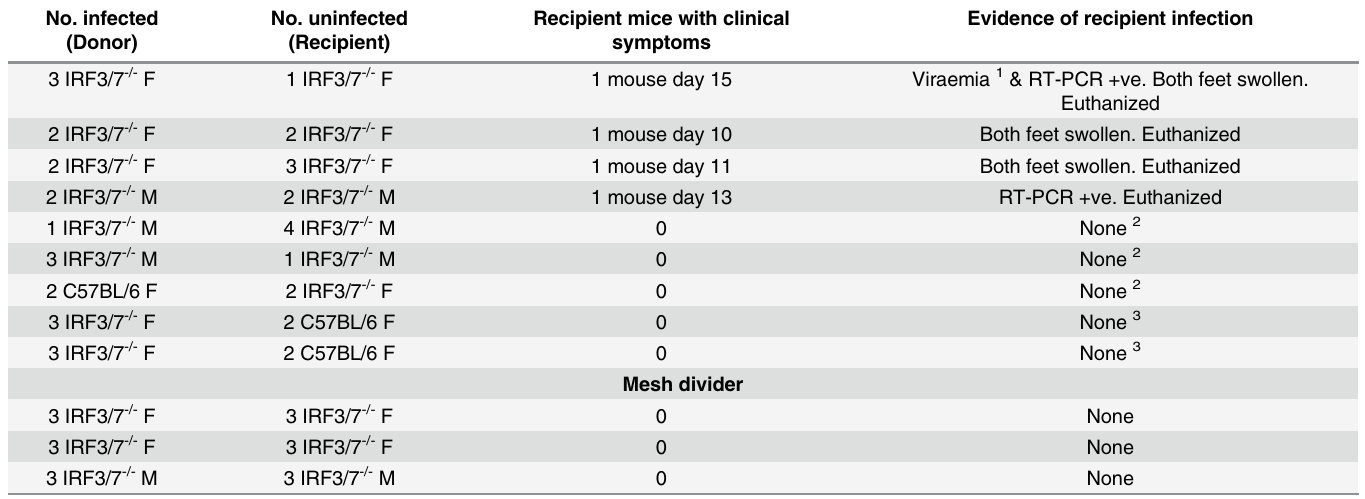
Table 1. Mouse-to-mouse transmission of CHIKV. Donor mice were infected with CHIKV and were then housed in the same cage as na ï ve Recipient mice. Infection of Recipient IRF3/7 -/- mice become apparent at the indicated times (Column 3) by onset of clinical symptoms (hunching, ruffled fur, swollen feet) indicating onset of CHIKV-induced hemorrhagic shock [6]. Samples for viraemia and/or RT-PCR were taken on the days indicated in Column 3. No. infected